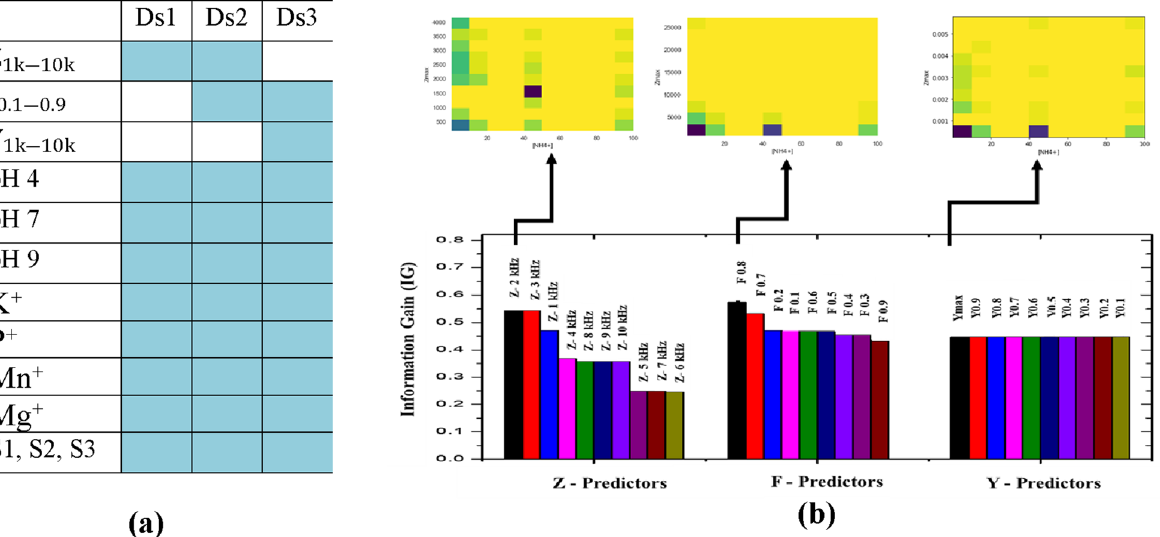
Figure 8. ( a ) Impedance spectral features and experimental parameters used as predictors in various datasets. ( b ) Information gain scores for Z, F and Y predictors. Insets show the variation in Z max values of predictors with maximum IG scores ( Z 2k , f 0.8 , Y max ).